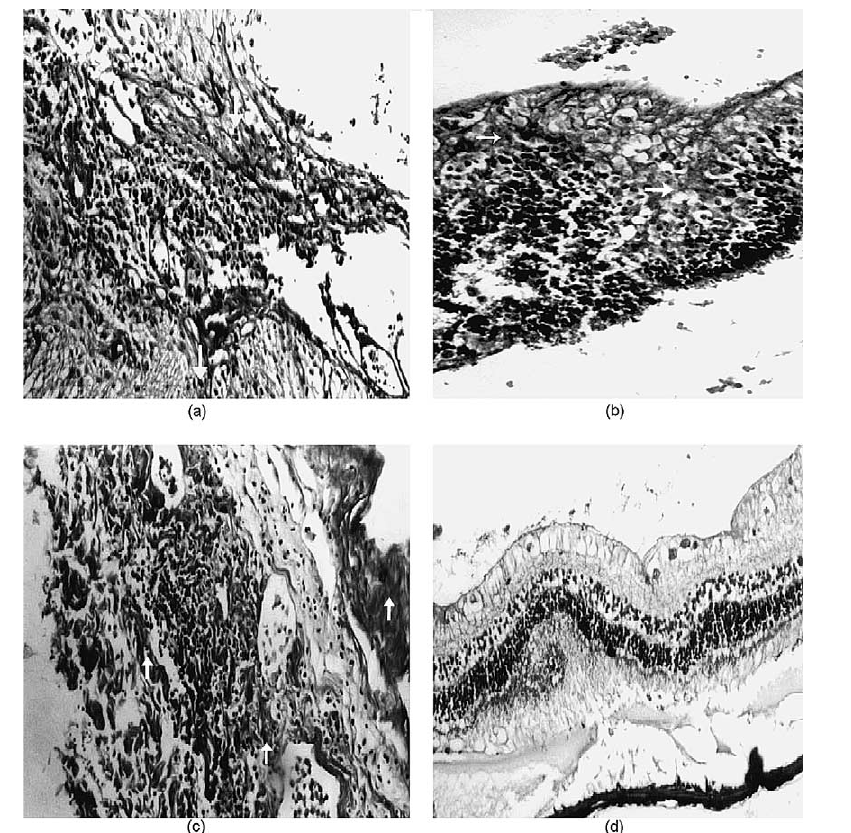
FIG. 1. (a) Normal retinal structure is generally preserved except a focus composed of connective tissue in group I. Arrows indicate collagen deposition (stain, Masson’s trichrome; original magnification, (cid:4) / 50). (b) Normal structure is extensively distorted with collagen deposition in group II eyes treated with cortisone. Arrows show collagen deposition (stain, Masson’s trichrome; original magnification, (cid:4) / 50). (c) The retina is replaced by connective tissue with large areas of collagen deposition in the blank group. Arrows exhibite collagen deposition (stain, Masson’s trichrome; original magnification, (cid:4) / 50). (d) Normal retina in the control group (stain, Masson’s trichrome; original magnification, (cid:4) / 50).